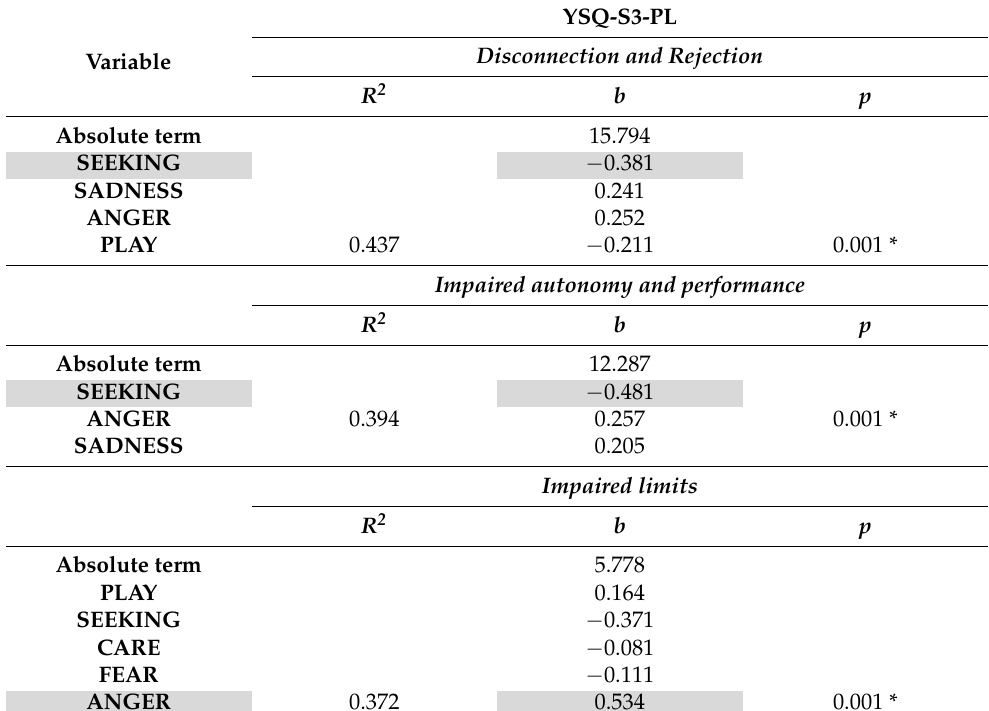
Table 5. Progressive stepwise regression coefficient results for the five domains of the YSQ-S3-PL questionnaire (dependent variables) and for the ANPS dimensions (independent variables) for the entire study group ( n =